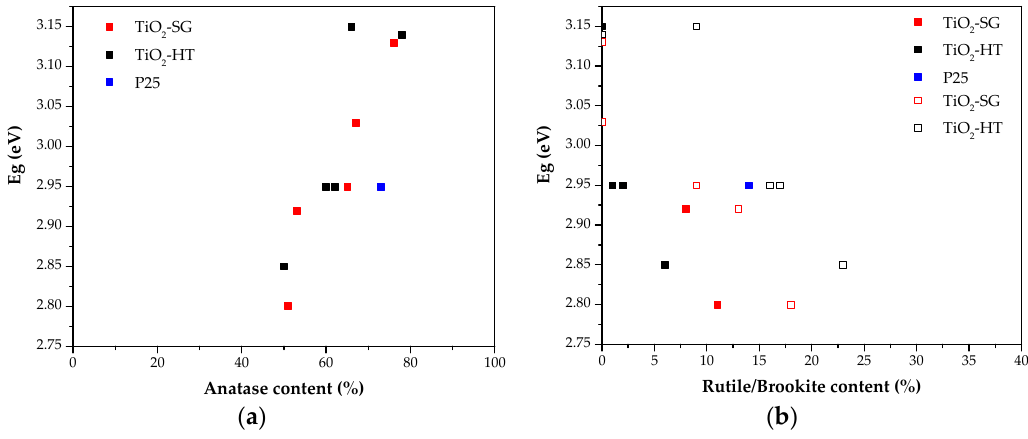
Figure 5. Band gap energy values for SG and HT photocatalysts: ( a ) versus anatase content and ( b ) versus the content of rutile (filled symbols) or brookite (empty symbols).